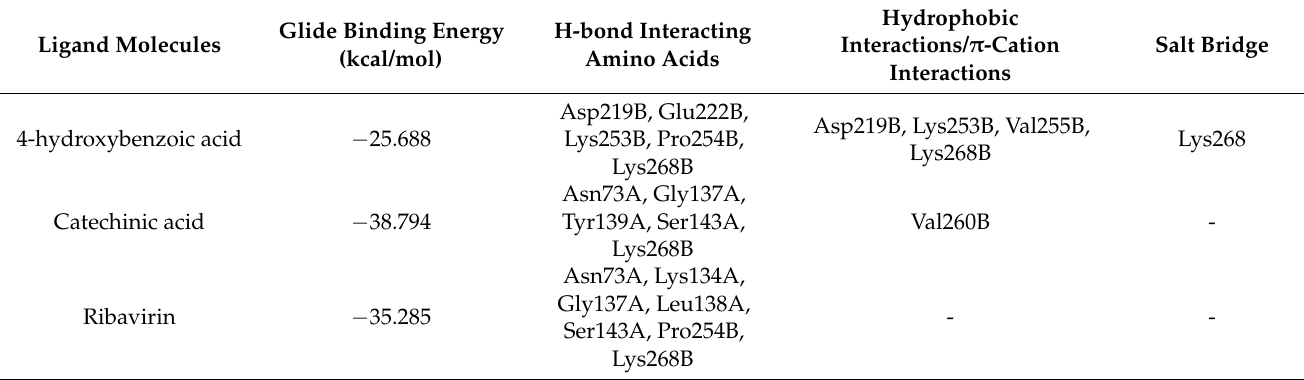
Table 3. Docking interaction parameters of the studied